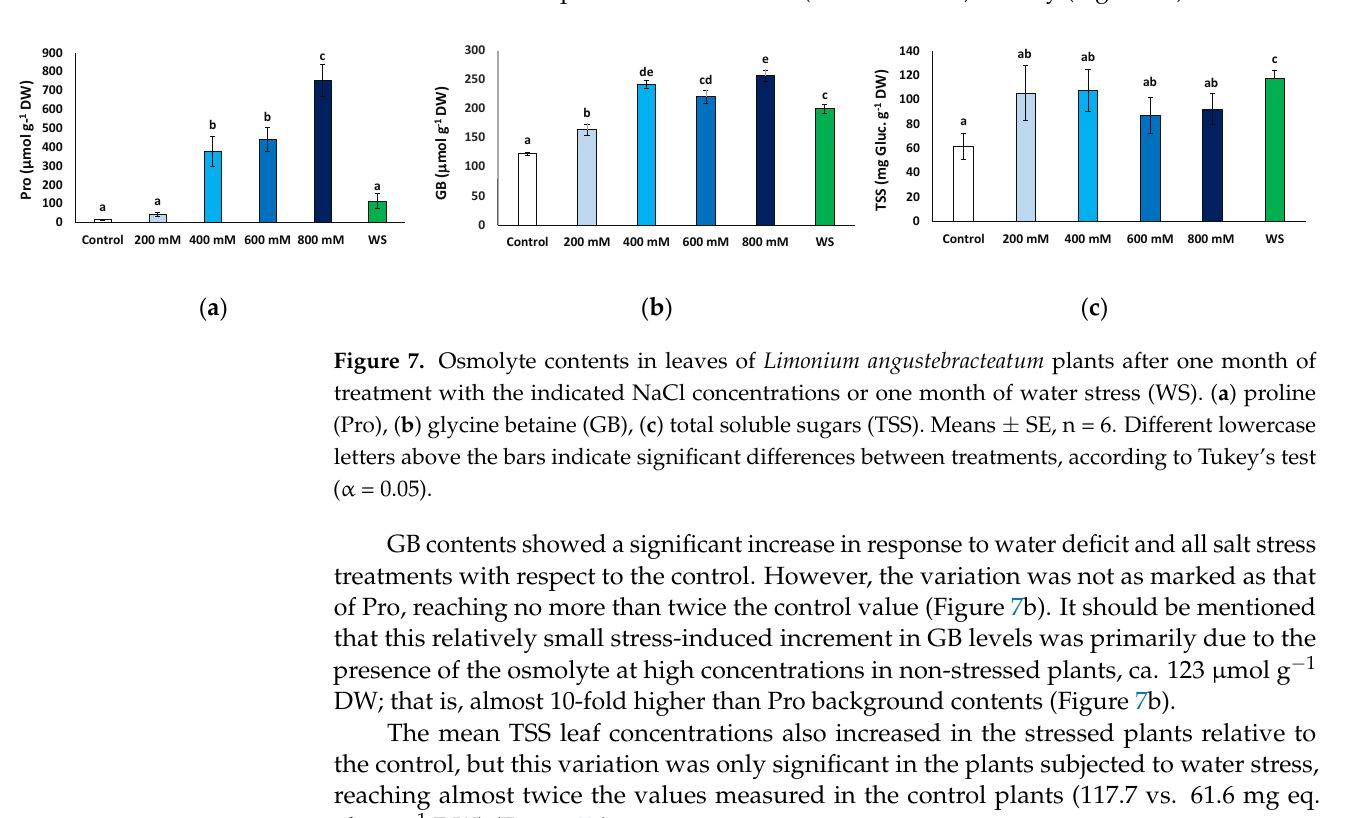
Table 1. Component weights in the PCA performed on Limonium angustebracteatum plants subjected to one month of stress treatments. Stronger correlations are shown in bold font. Abbreviations: LNo, number of leaves; LA, leaf area; RFW, root fresh weight; LFW, leaf fresh weight; RWC, root water content; LWC, leaf water content; Chl a, chlorophyll a; Chl b, chlorophyll b; Caro, carotenoids; Na +r, sodium in roots; Na +l sodium in leaves; Cl −r , chlorine in roots; Cl −l , chlorine in leaves; K +r , potassium in roots; K +l , potassium in leaves; Ca 2+r , calcium in roots; Ca 2+l , calcium in leaves; Pro, proline; GB, glycine betaine; TSS, total soluble sugars.